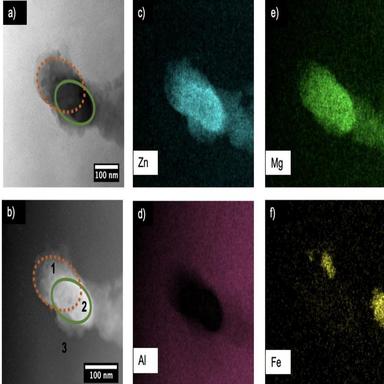
High magnification BF-STEM and HAADF-STEM micrographs of Al-14Zn-3Mg are shown in (a) and (b), respectively, and their corresponding EDXS maps are presented (c-f). The features labelled as 1 and 2 indicate two individual particles that coexist and feature 3 indicates the Al-matrix. The individual compositions of those features are tabulated in at. %, showing compositional variation that existed within the mapped region.